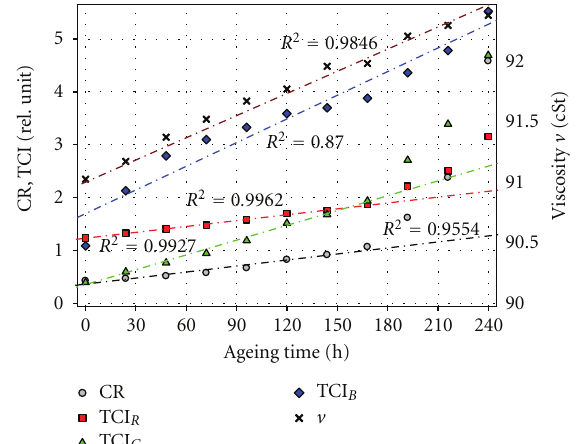
Figure 10: CR, TCI and viscosity variation with ageing time of T100 oil.